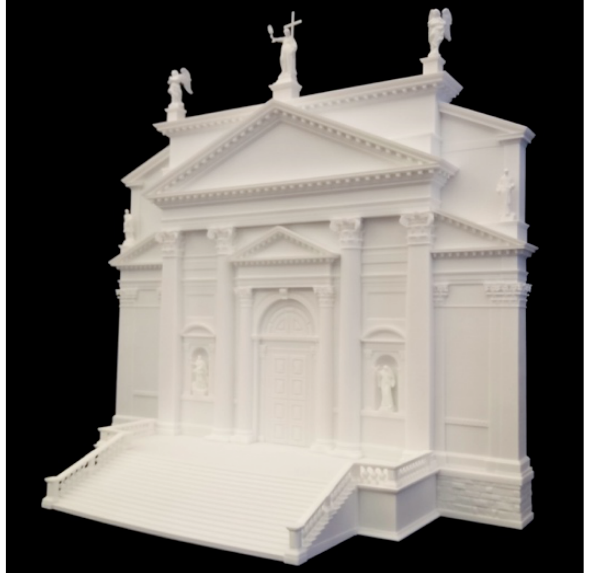
Figure 1. 3D printed model of Redentore Church in Venice realised with Selective Laser Sintering Observations and comparison of dimensional and constructive details become natural through the process of exploration, adding value to the procedure, from the point of view of the historical and artistic